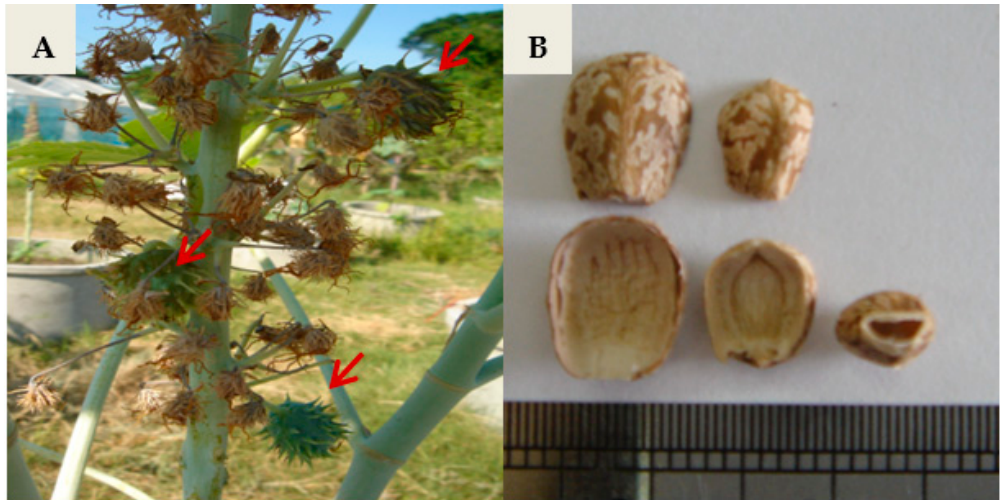
Figure 3. Development of ( A ) fruits and ( B ) seed set of F 1 hybrid from reciprocal cross between R . communis ( ♀ ) and J . curcas ( ♂ ).